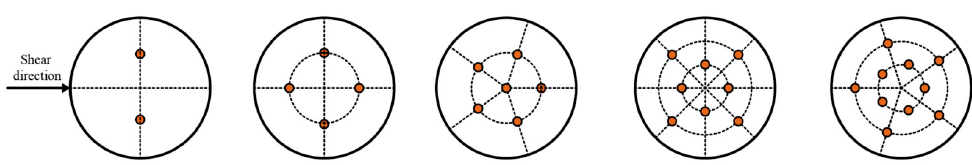
Figure 11. Distribution of roots in the shear box.